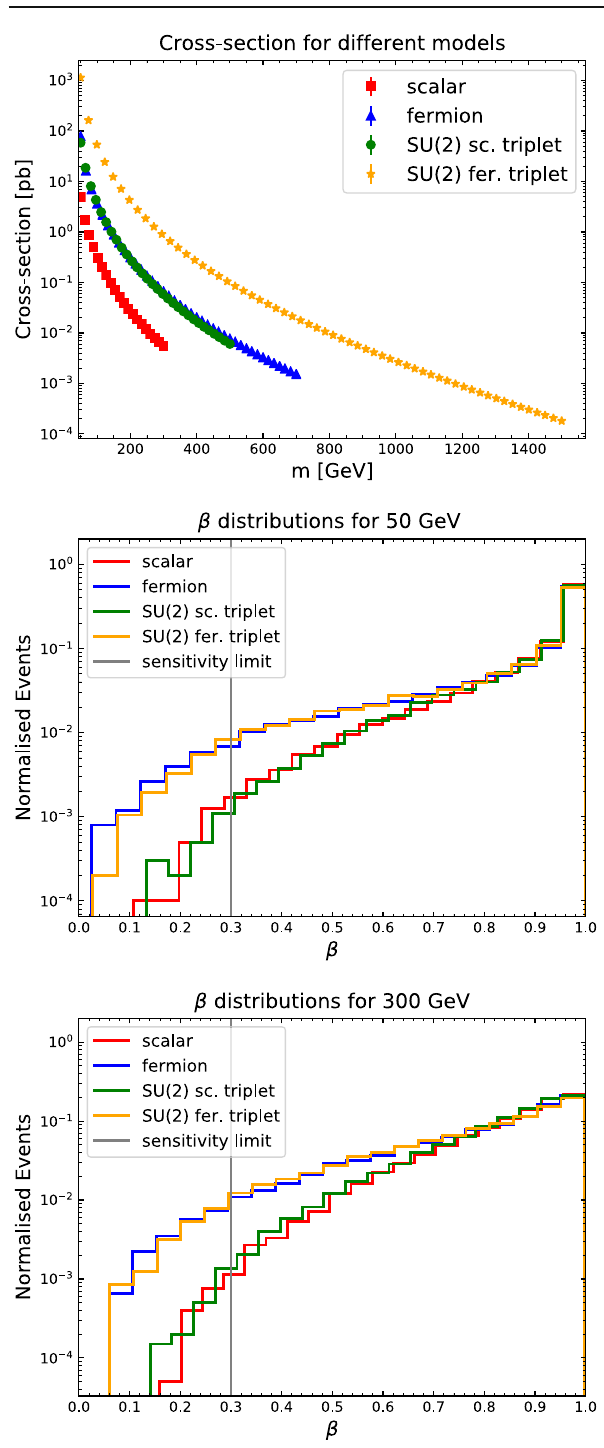
Fig. 4 Top panel: the leading-order production cross-sections at 13 TeV for various types of doubly-charged particles. Middle and lower panels: the velocity distributions for various doubly-charged particles with masses 50 and 300 GeV